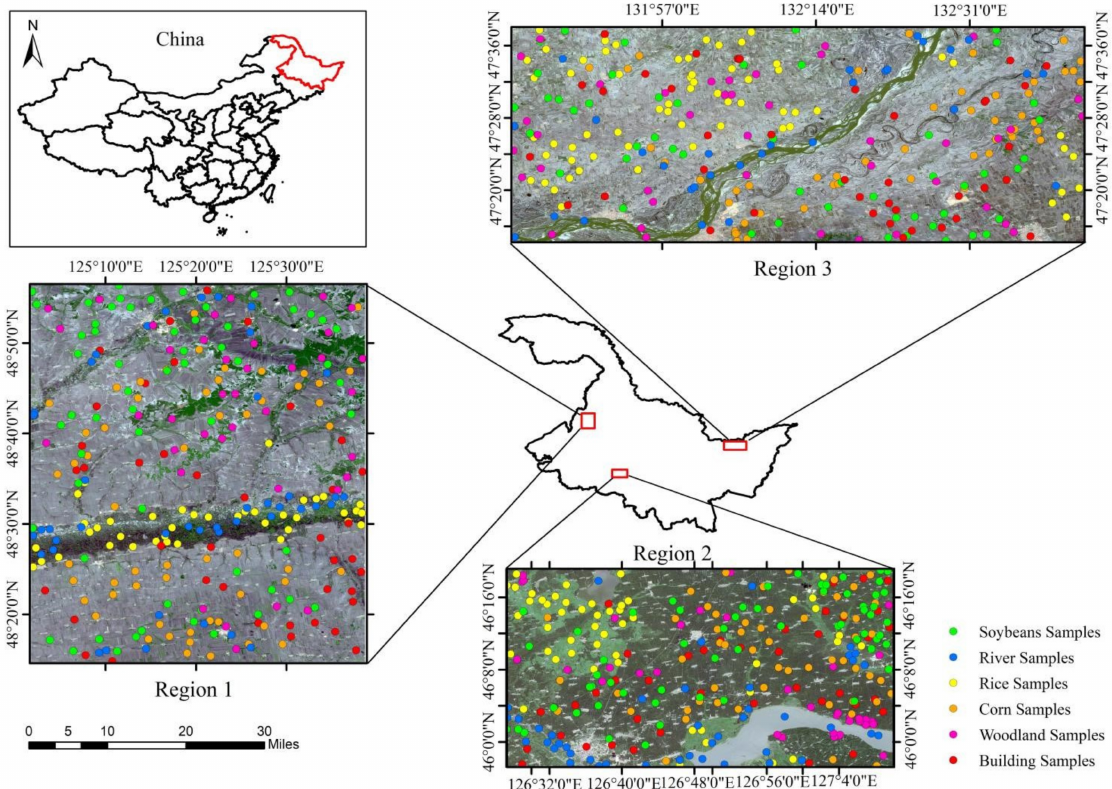
Figure 1. Location of the three regions. Region 1 (125 ◦ 02 (cid:48) E–127 ◦ 64 (cid:48) E, 48 ◦ 24 (cid:48) N–48 ◦ 94 (cid:48) N) is located on the Songnen Plain. The